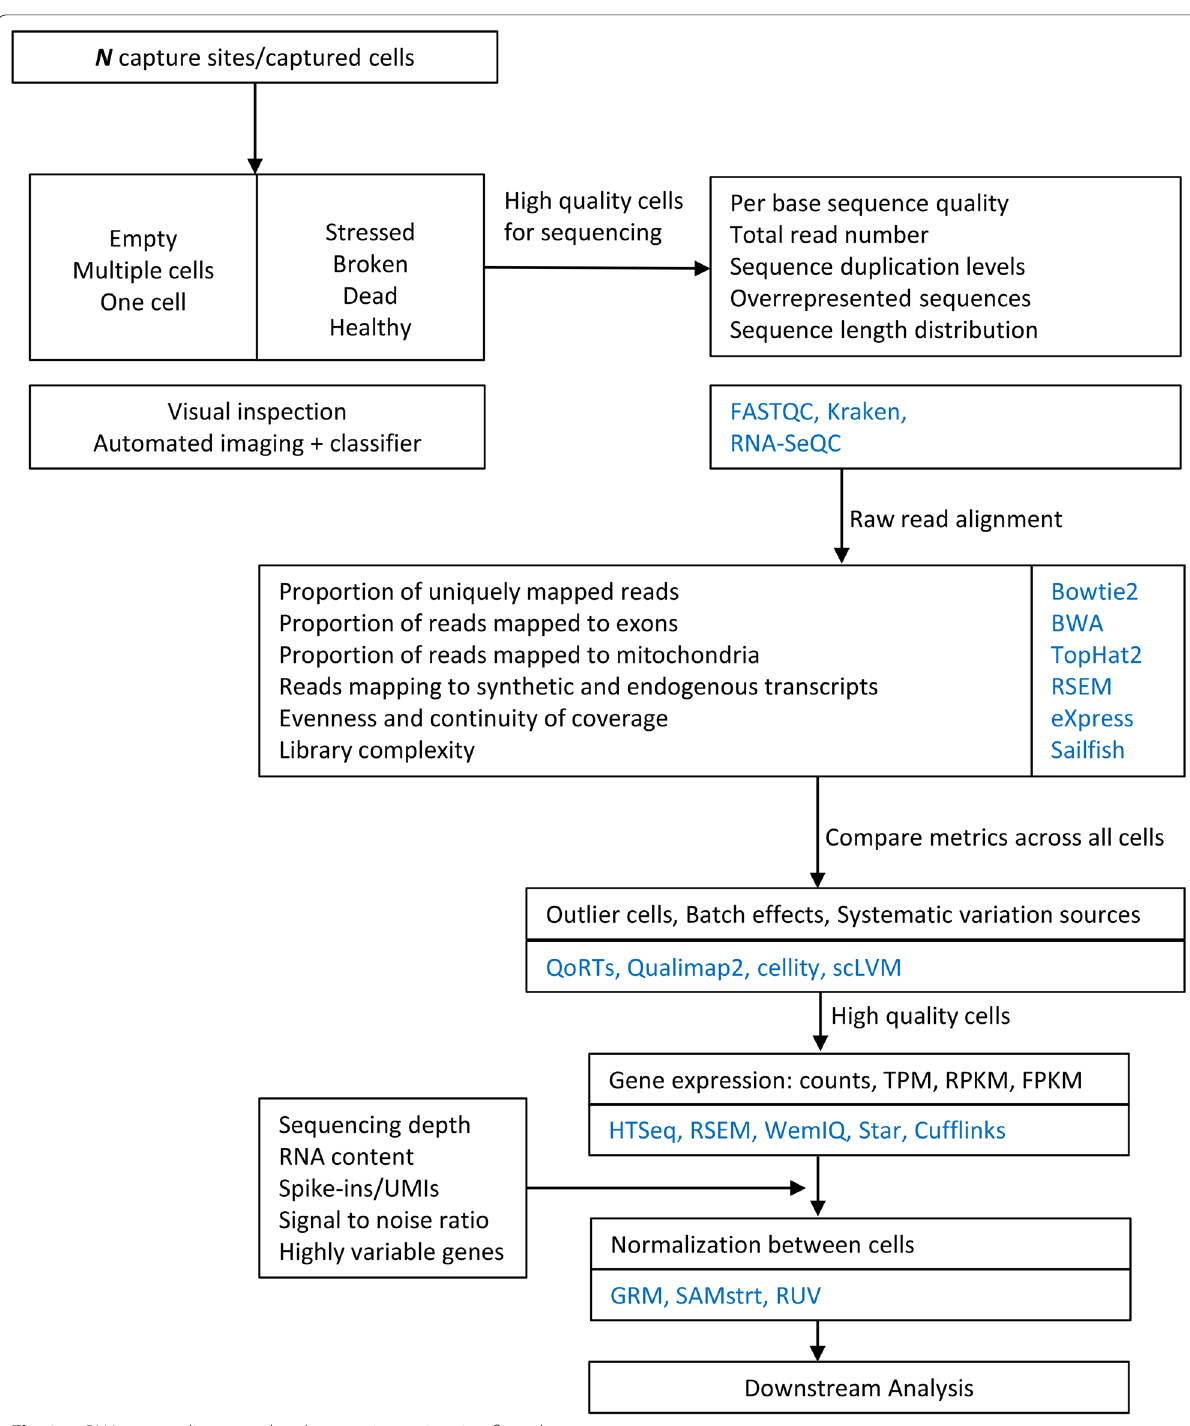
Fig. 3 scRNA‑seq quality control and expression estimation flow